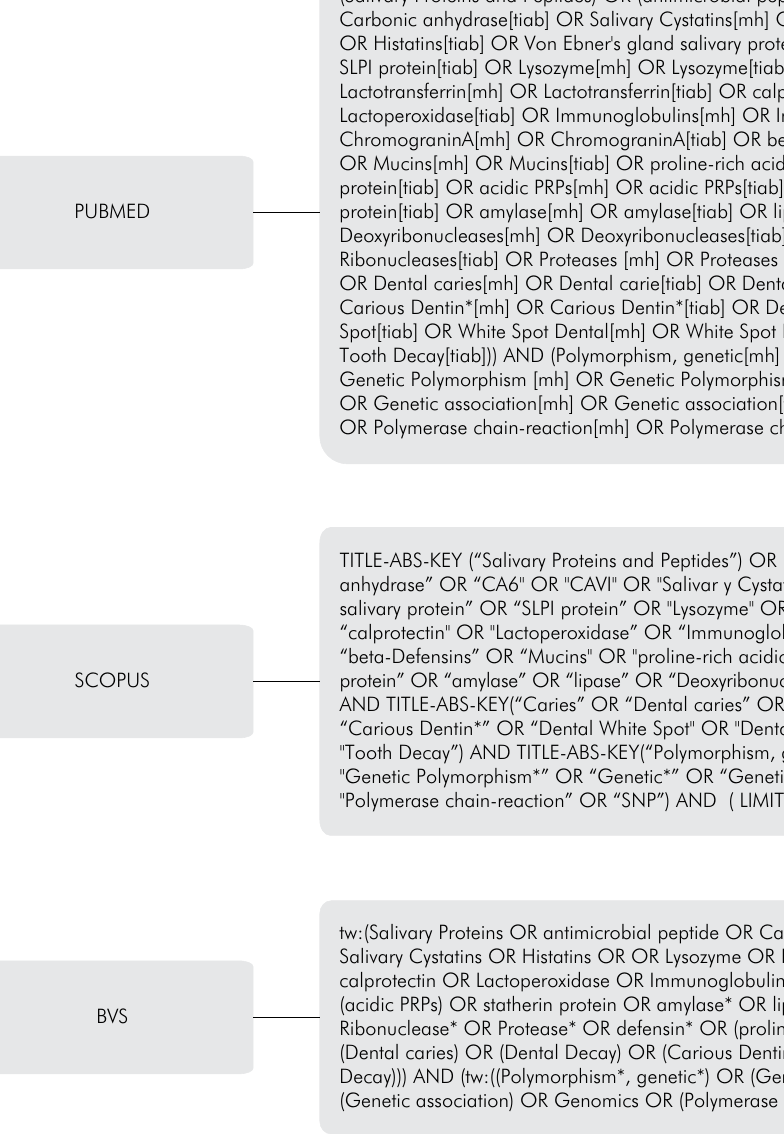
Figure 1. Terms for each database search strategy